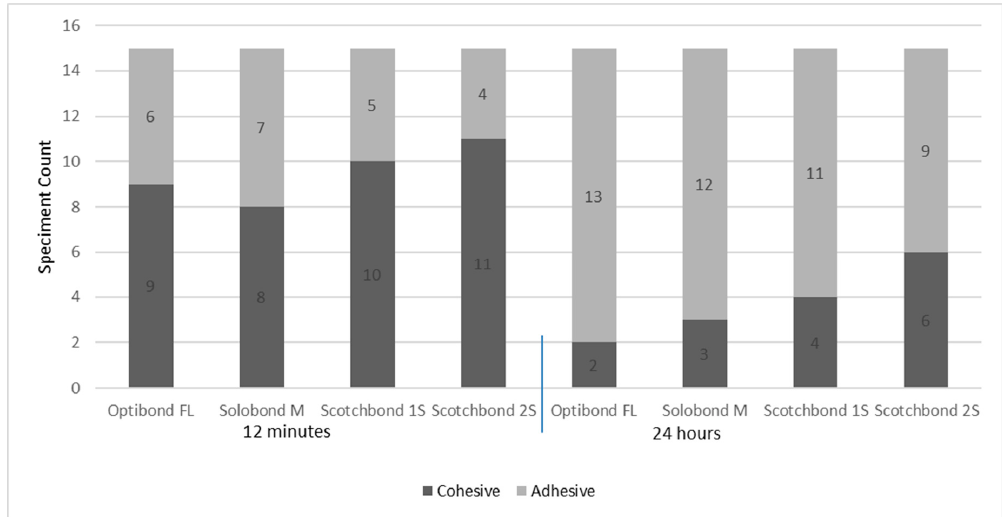
Figure 1. Failure mode in different experimental groups.